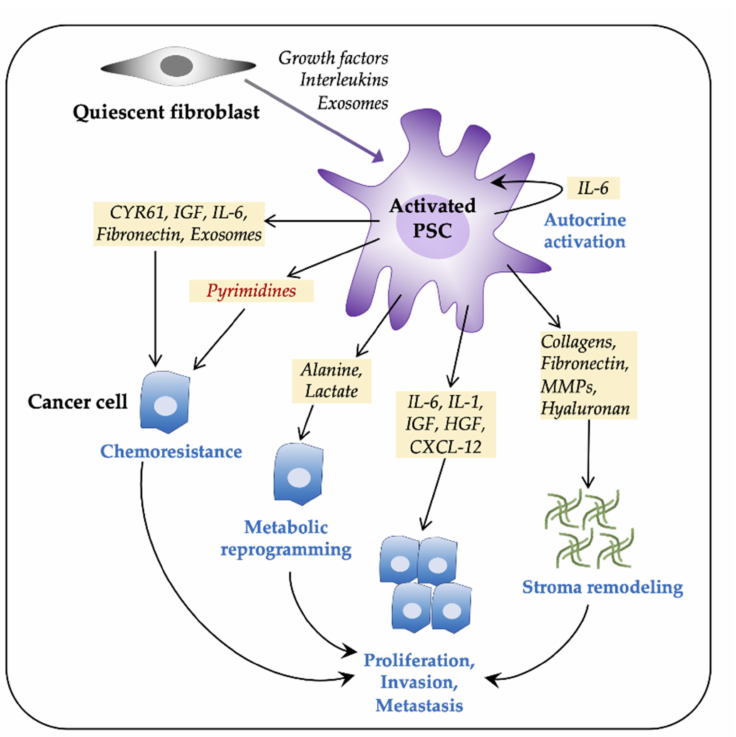
Figure 1. Pancreatic stellate cells (PSCs) facilitate tumor progression in pancreatic ductal adeno- carcinoma (PDAC). Pancreatic tumors consist of a large number of activated fibroblasts, which are myofibroblast-like cells and are referred to as PSCs. Fibroblasts are activated by both paracrine and autocrine signals. Activated PSCs promote cancer cell proliferation, invasiveness, metasta- sis, and chemoresistance via various paracrine, exosome-mediated, or autophagic mechanisms. PSCs contribute to tumor progression by metabolic reprogramming and by extracellular matrix components-mediated stromal remodeling. CXCL12, C-X-C motif chemokine 12; CYR61, cysteine- rich angiogenic inducer 61; HGF, hepatocyte growth factor; IL, interleukin; IGF, insulin-like growth factor; MMPs, matrix metalloproteinases; PDAC, pancreatic ductal